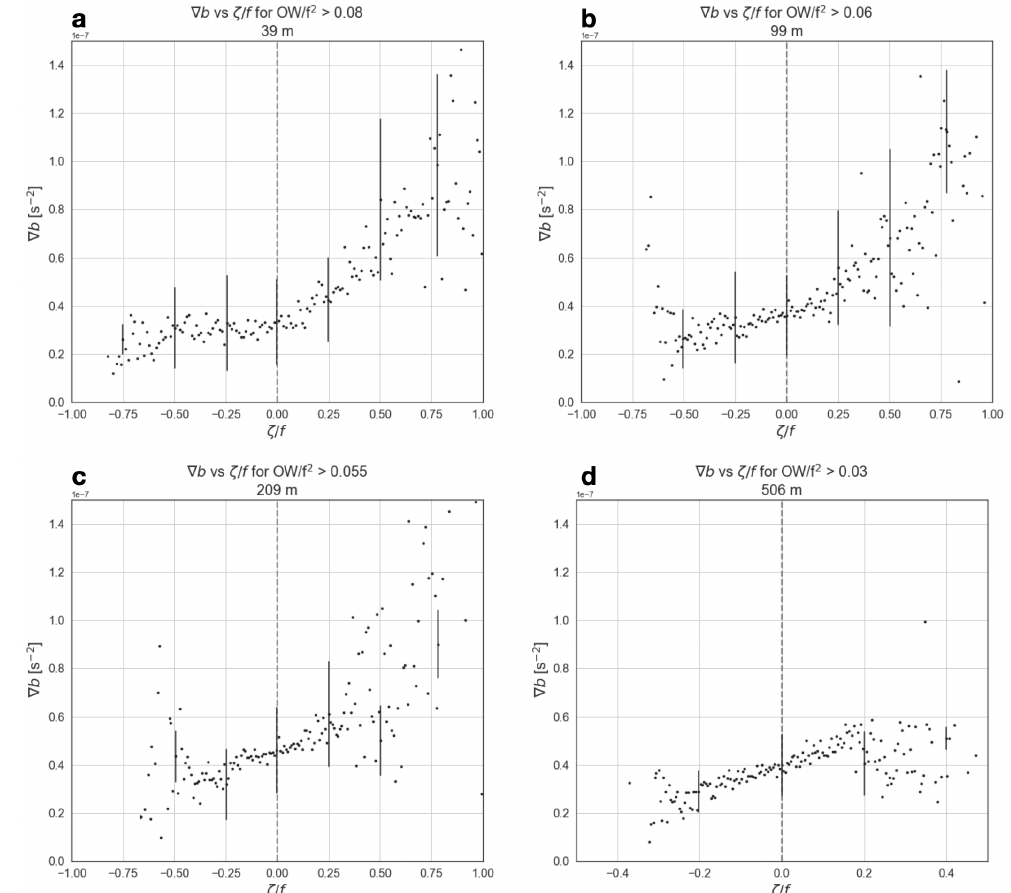
Figure 4. Scatter plots of |∇ b | and ζ / f partitioned by Okubo-Weiss/ f 2 such that ∼ 20% of the domain points are kept in order to exclude coherent vortices and retain fronts and filaments (see main text, Equation (A3) in Appendix A and Roullet and Klein [27] for more details) at ( a ) 39 m, ( b ) 99 m, ( c ) 209 m, ( d ) 506 m. Randomly selected snapshot on 27 October 2011 00:00:00 UTC. Dots corresponds to an average over each grid interval on the abscissa (that has a total of 200 grid intervals), and thin vertical lines show std dev around the average. There is a strong asymmetry between positive and negative ζ / f and |∇ b | , highlighting the ageostrophic